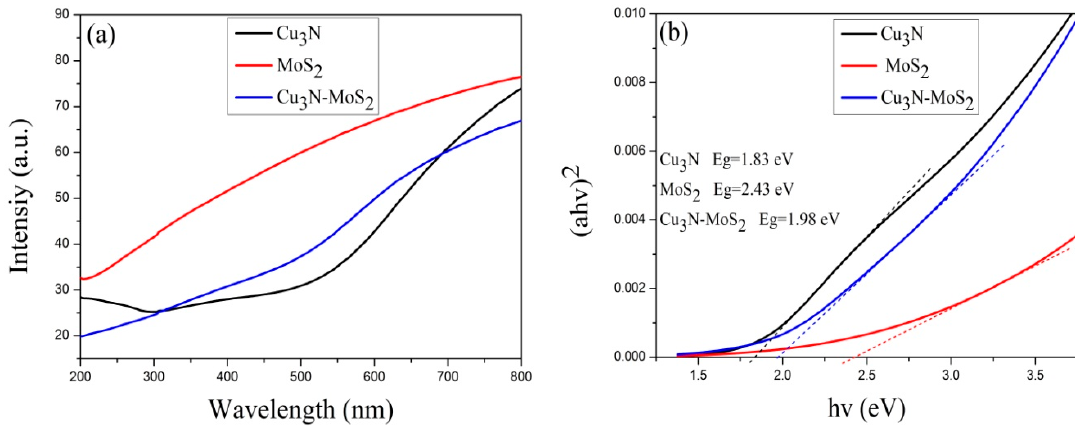
Figure 6. ( a ) Ultraviolet-visible (UV-vis) transmission spectrum of the Cu 3 N/MoS 2 heterojunction and ( b ) determination of optical band gap of the Cu 3 N/MoS 2 heterojunction.